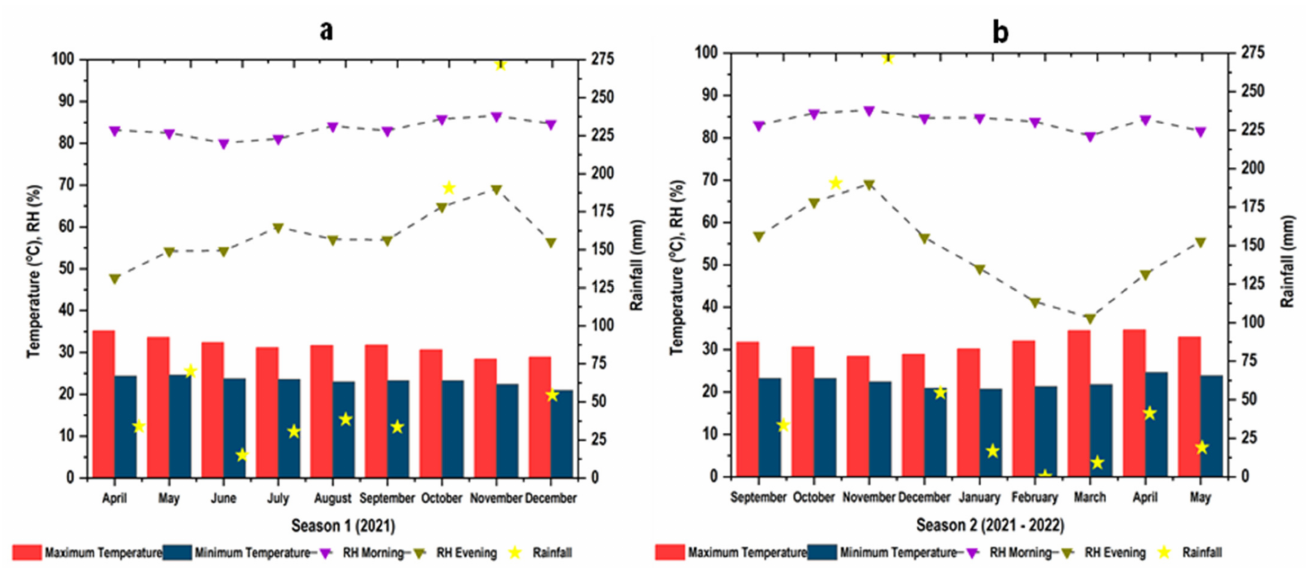
Figure 2. Monthly metrological weather data for ( a ) season 1 (2021) and ( b ) season 2 (2021–2022) at Coimbatore, Tamil Nadu,